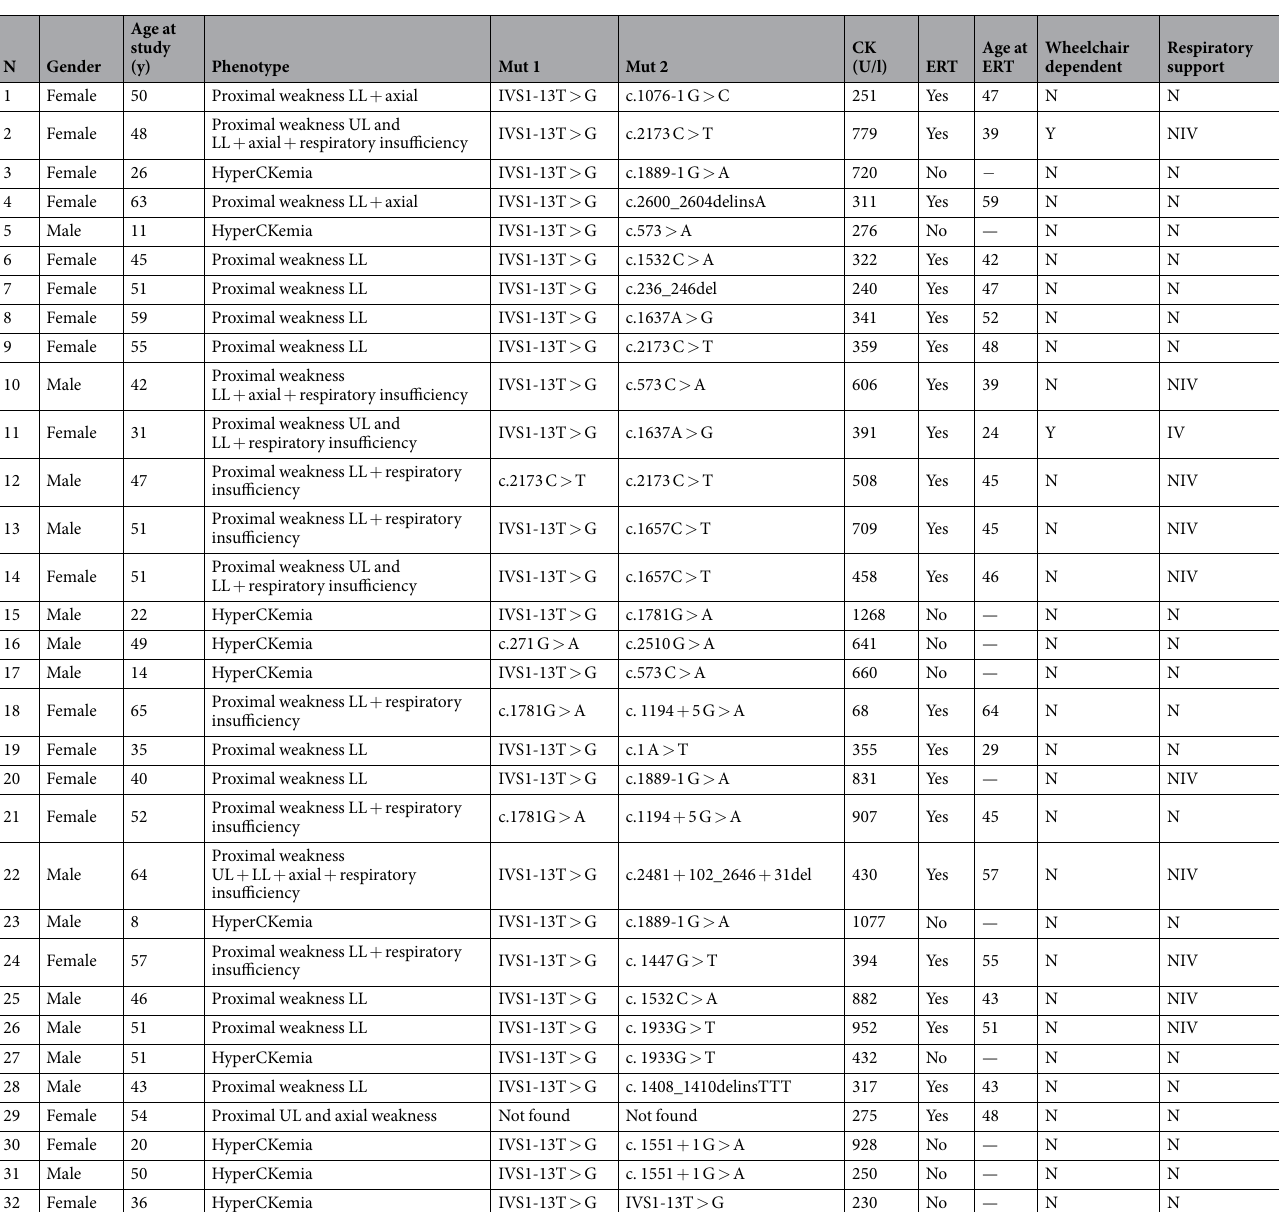
Table 1. Clinical characteristics of the cohort of LOPD patients participating in the study. Normal CK levels were lower than 170 U/L. Patients 13 and 14 and patients 26 and 27 were siblings. Respiratory support: NIV means non-invasive ventilation while IV means invasive ventilation. UL: Upper limbs, LL: lower limbs, Y: yes, N: